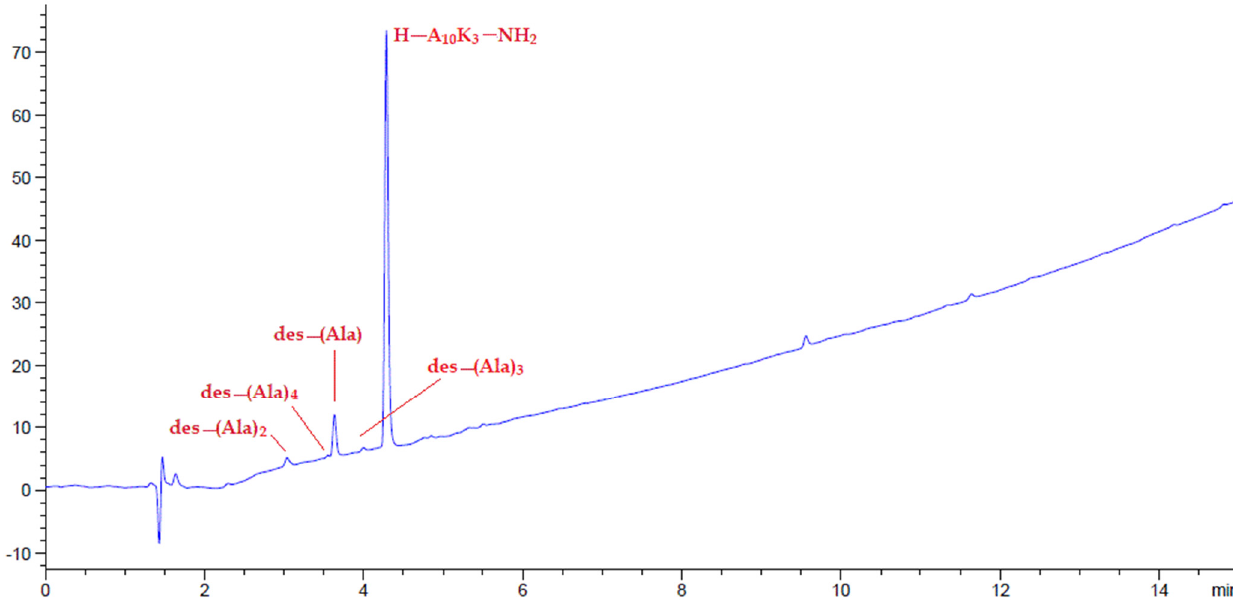
Figure 10. HPLC chromatograms of crude peptides H-(Ala) 10 (Lys) 3 -NH 2.